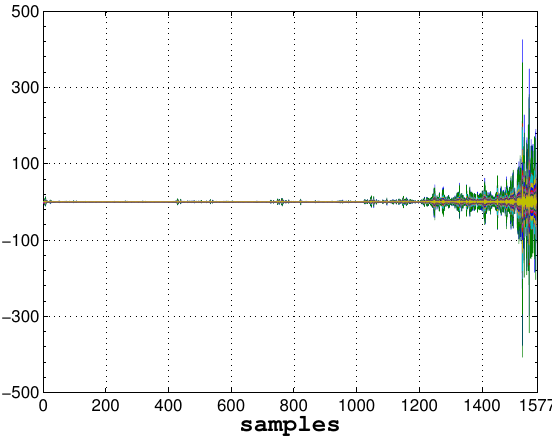
Figure 8. Example 4. Estimated coefficients.